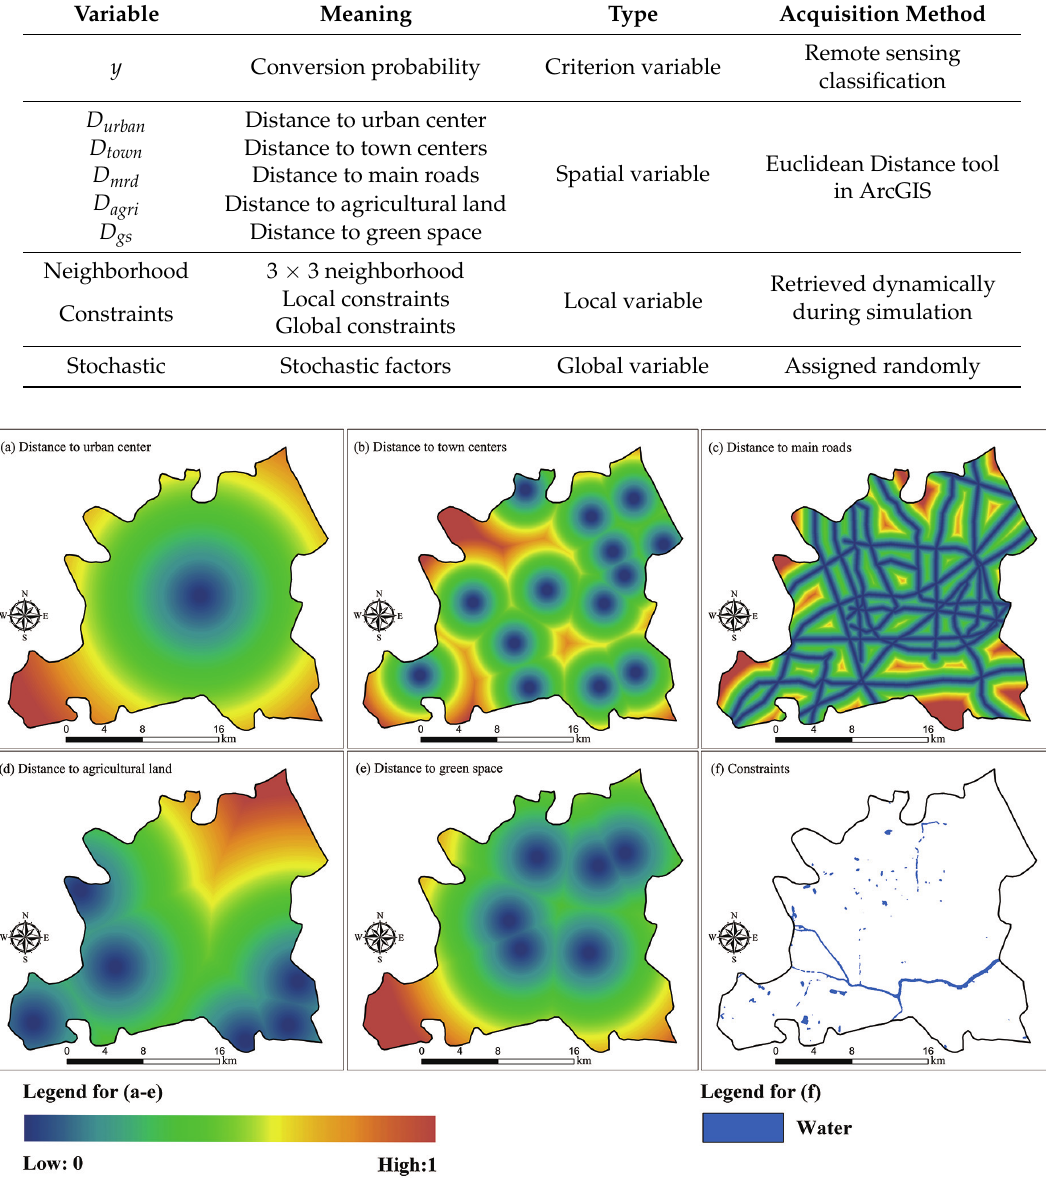
Figure 2. Visualization of spatial variables used in the PLS-CA model. ( a ) D urban ; ( b ) D town ; ( c ) D mrd ; ( d ) D agri ; ( e ) D gs ; and ( f ) Constraint. ( d ) D agri ; ( e ) D gs ; and ( f )